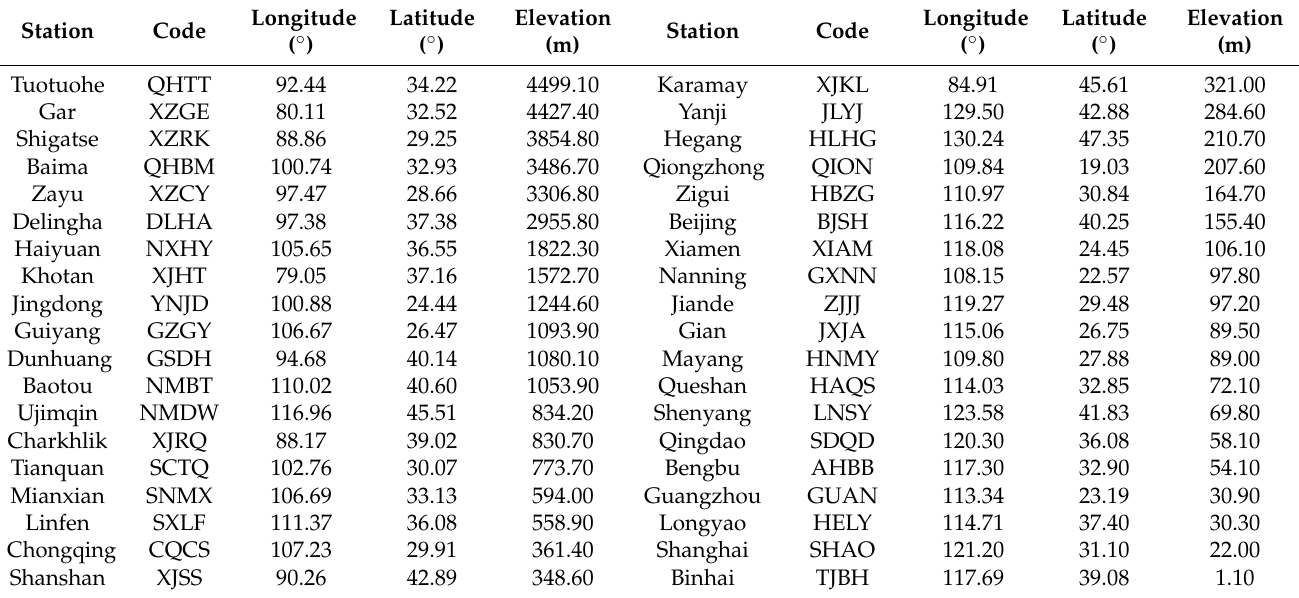
Table 1. Locations of 38 GNSS stations for PWV modelling in the China region.